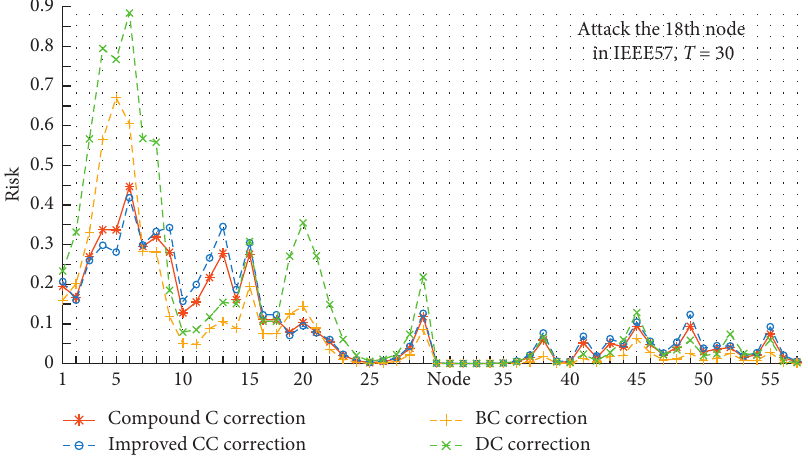
Figure 8: Risk of node under compound C, improved CC, BC, and DC correction at T �